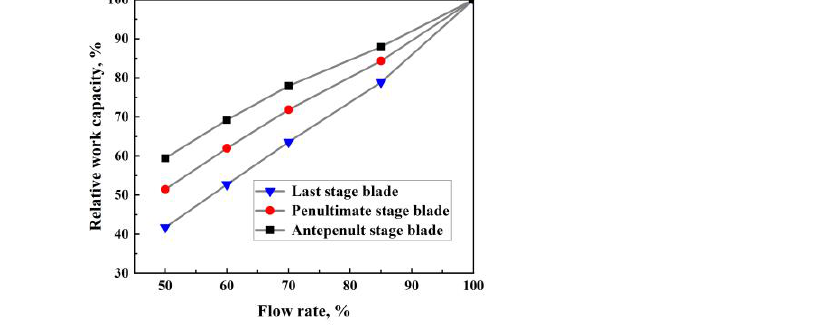
Figure 14. Amount of work performed by the last three stage blades (2.7 MPa back pressure).